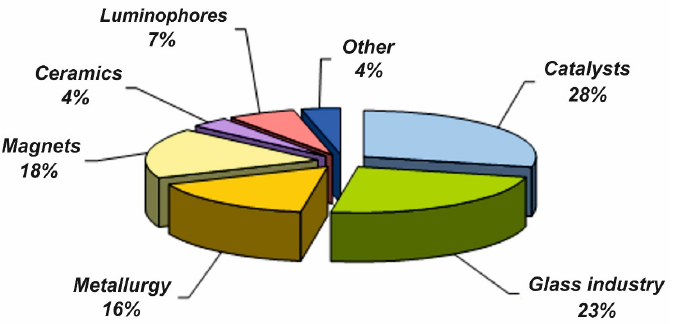
Figure 1. World’s consumption pattern of REM [3].